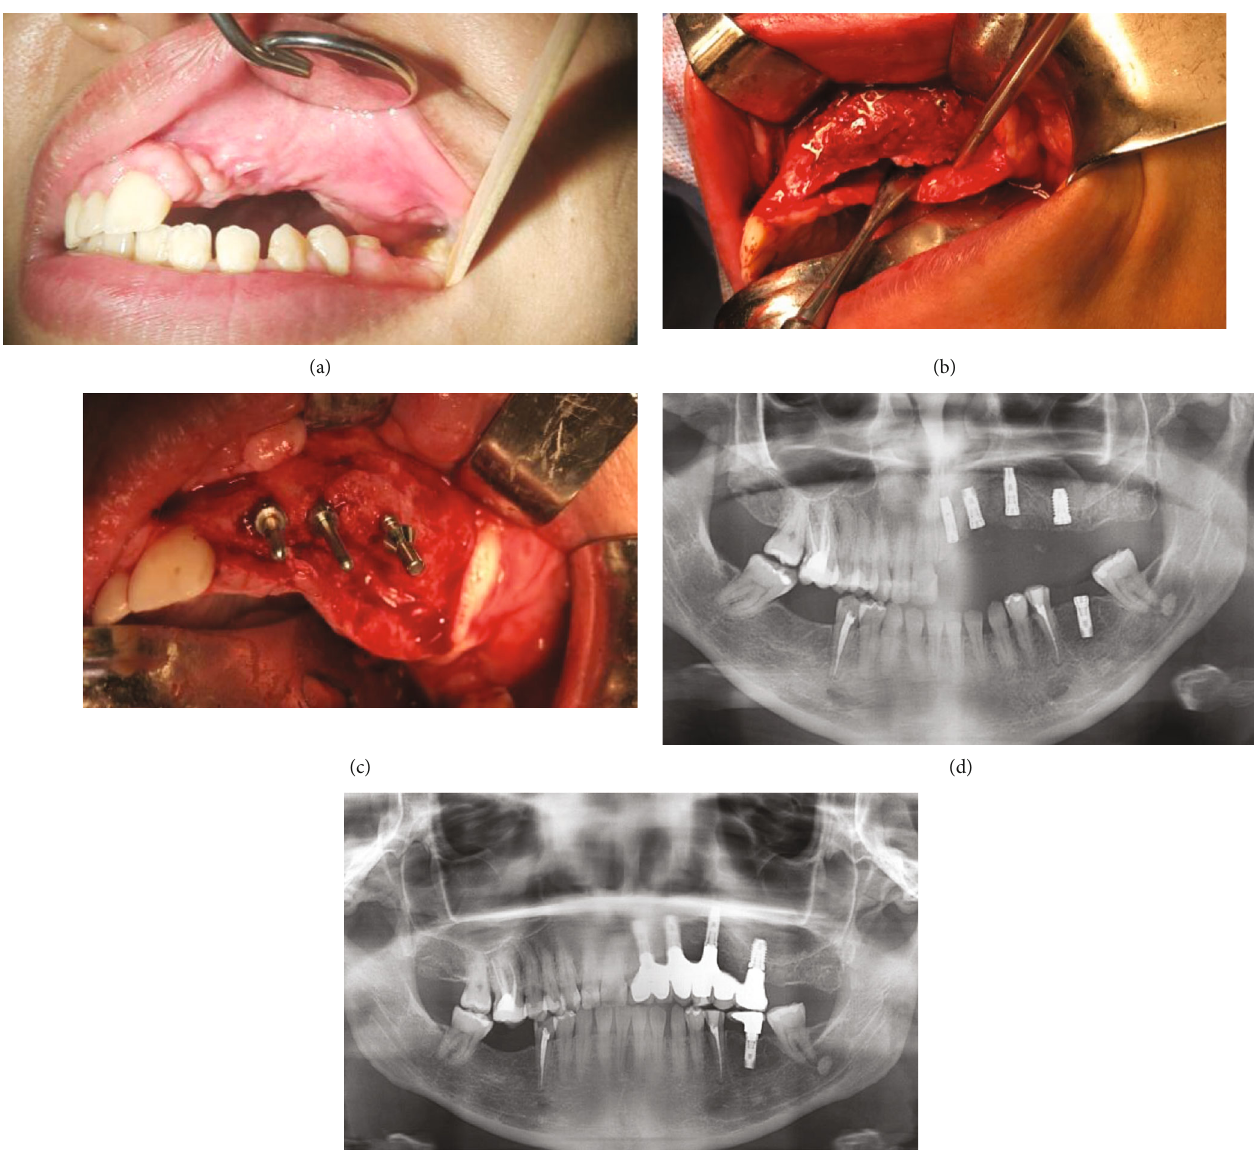
Figure 4: (a) Six months postoperation. (b) Exposing and removing the mesh. (c) Implant placement. (d) Radiograph of bone graft at 8- month follow-up. Note: the signi fi cant increase in bone augmentation of the maxilla and implant rehabilitation. (e) Complete regeneration in 3 years following reconstruction of the maxillary